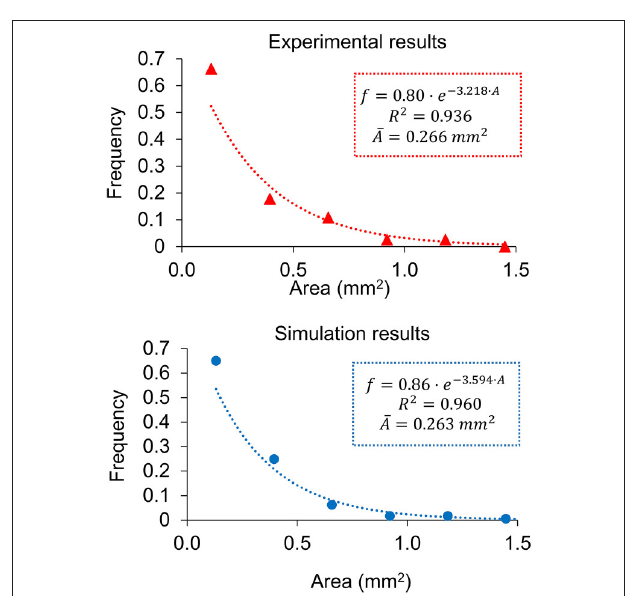
FIGURE 5 | Distribution of individual lesion areas at day 21 for the experimental data (red triangles, up) and the simulation results (blue circles, down), with the exponential fittings. Both correspond to series